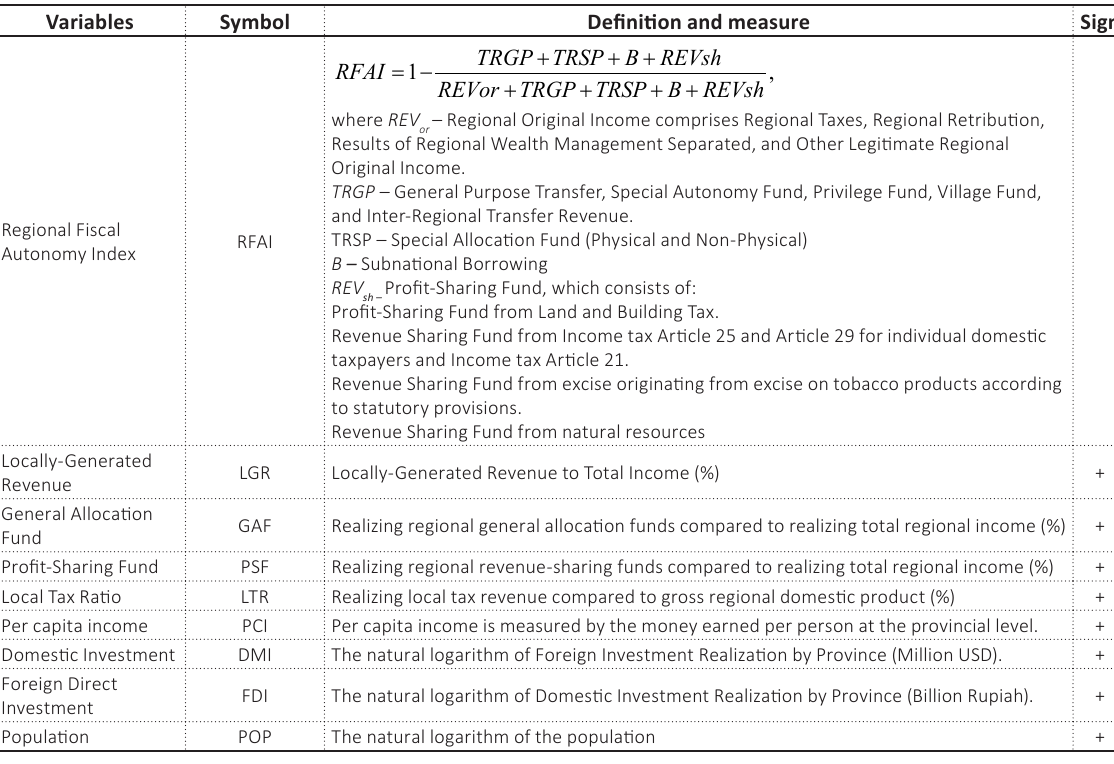
Table 2. Classification of regional fiscal